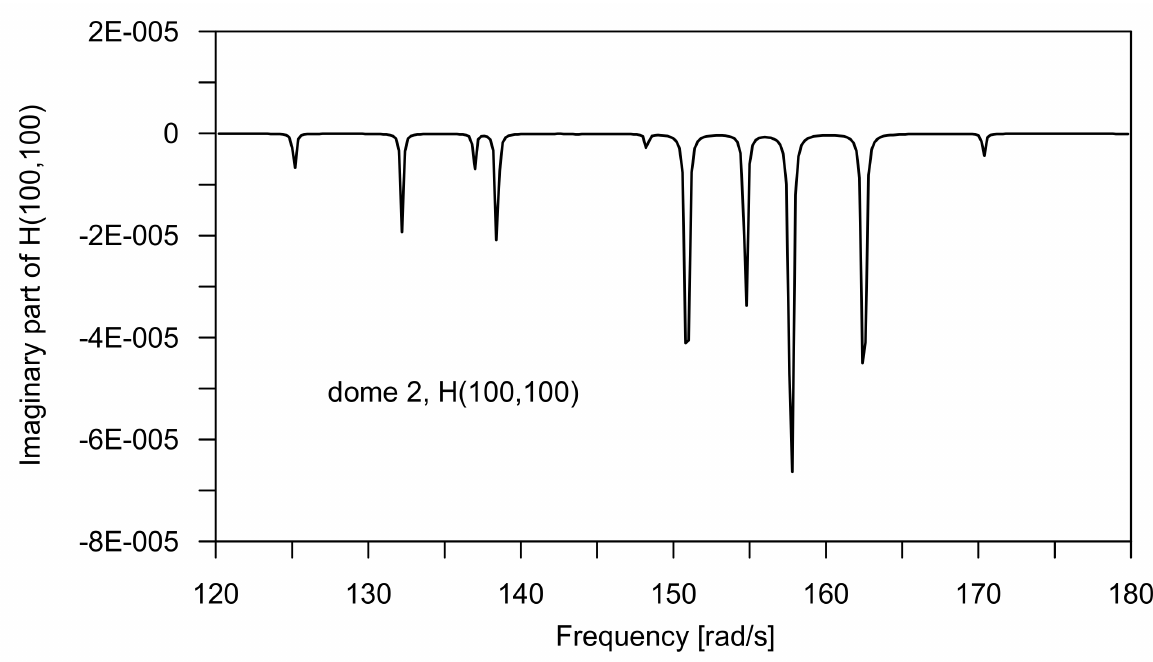
Figure 14. Imaginary part of the representative frequency response